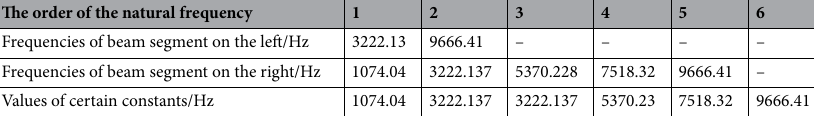
Table 4. Values of natural frequencies.